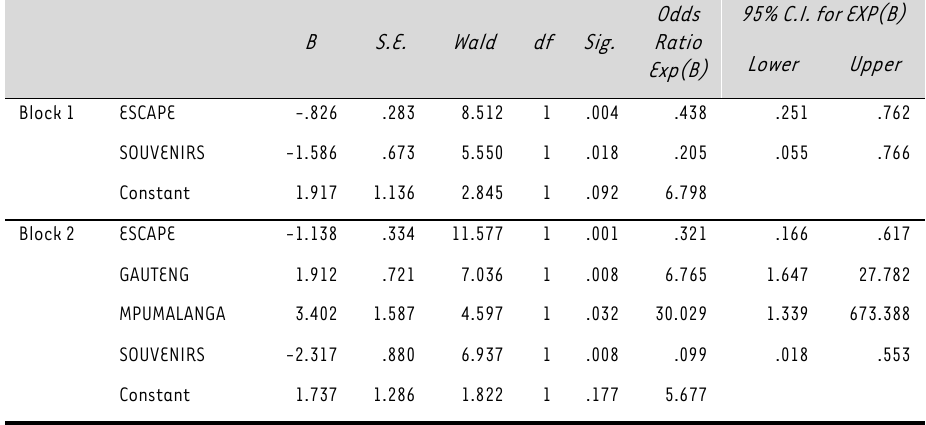
TABLE 7: Results from hierarchical stepwise logistic regression: Influence on demand for KNP